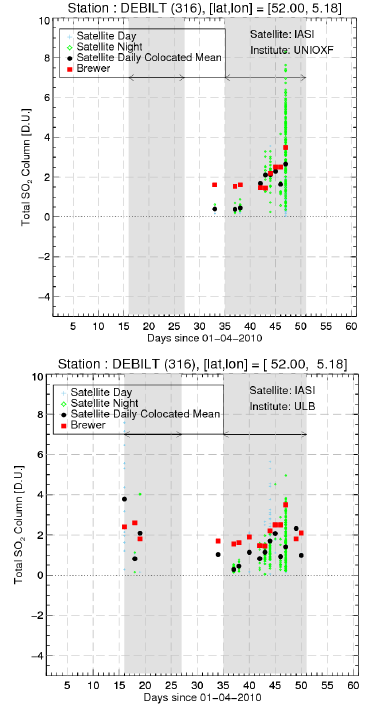
Figure 3: Total SO 2 load over De Bilt, The Netherlands. Details in the